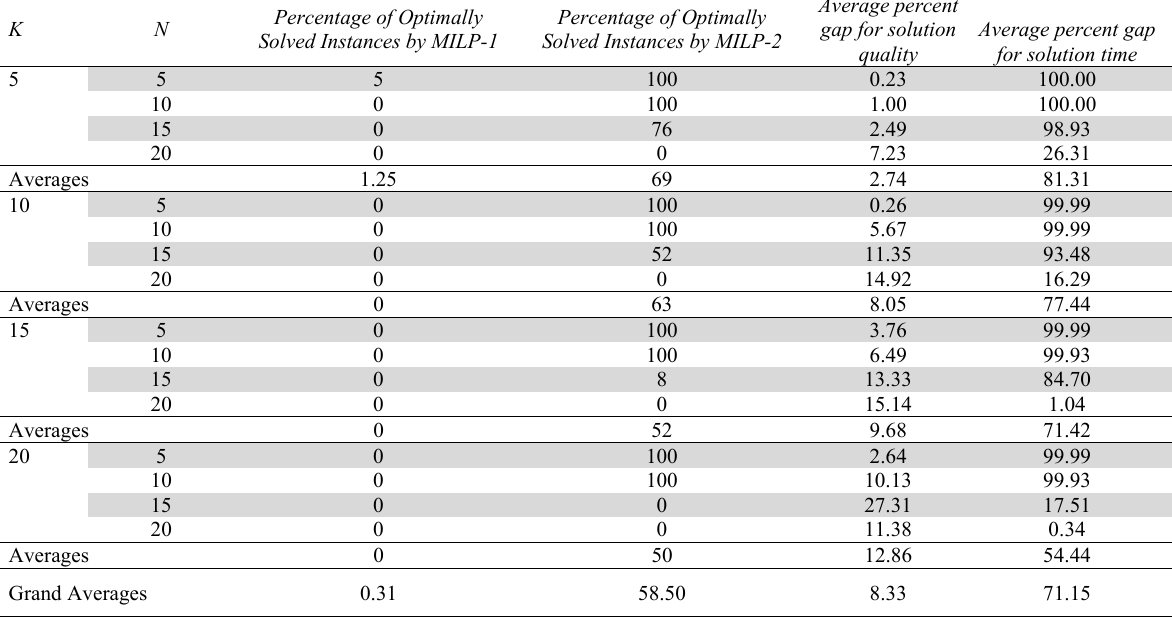
Comparison of the MILP-1 and MILP-2